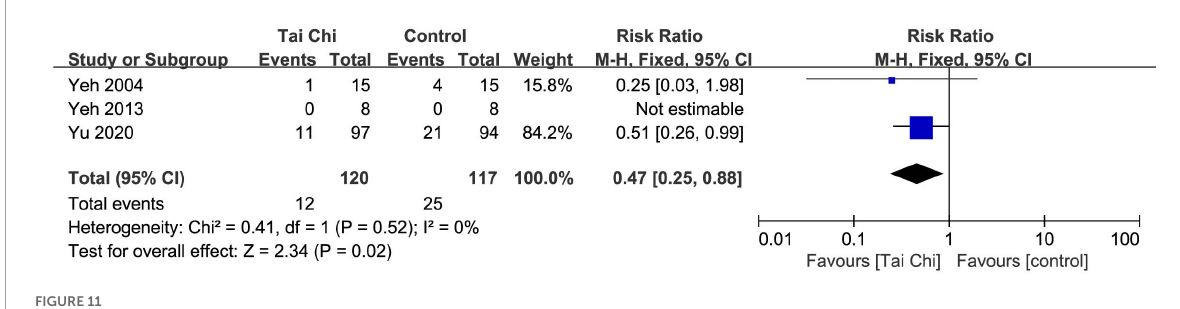
Table 3 . There was moderate-quality evidence on TUGT and heart failure hospitalization; low-quality evidence on